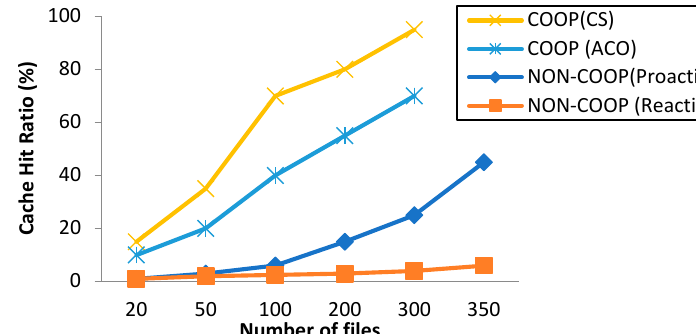
Figure 10. Cache hit ratio with increasing number of files.